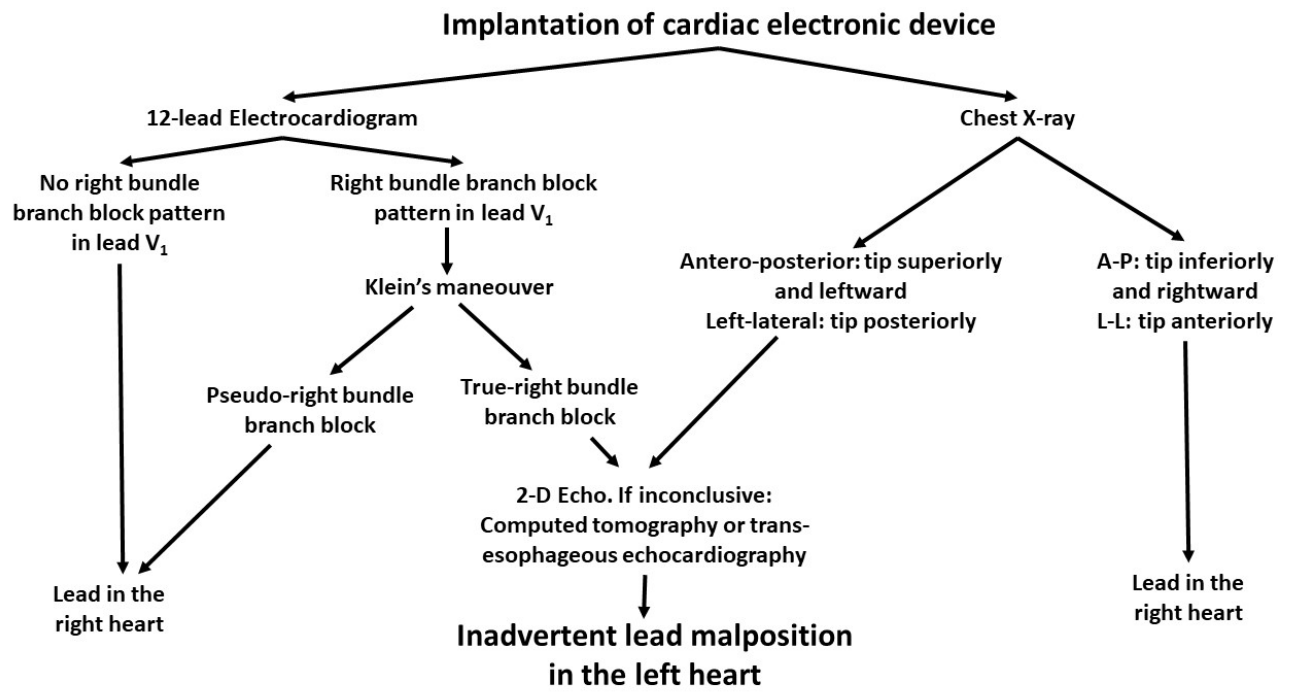
Figure 2. Suggested diagnostic algorithm. A right bundle branch block morphology in V1 on the ECG despite Klein’s maneuver or an atypical position on the chest X-ray should prompt further investigations to rule out lead malposition.